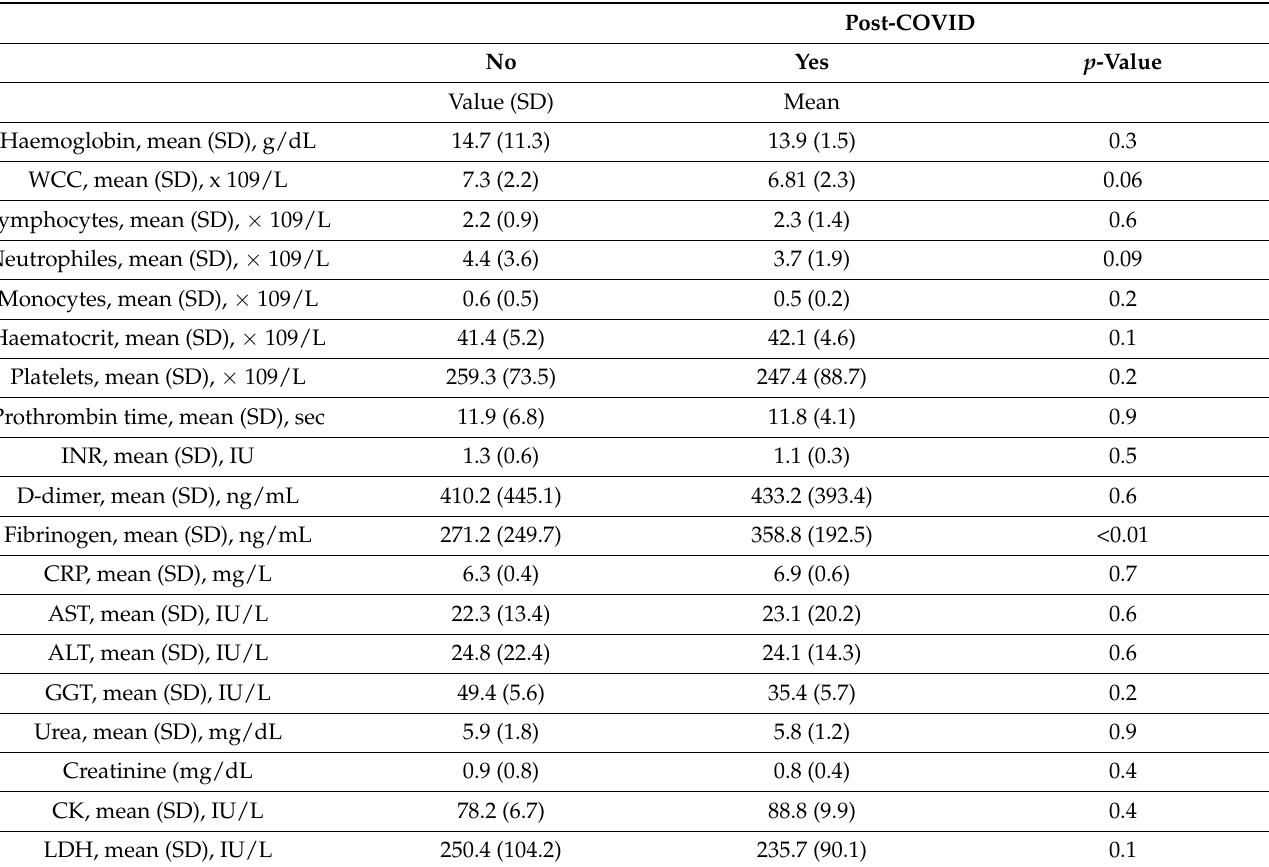
Table 4. Laboratory parameters in patients with invasive mechanical ventilation based on persistent post-COVID-19 symptoms at 3-month follow-up.